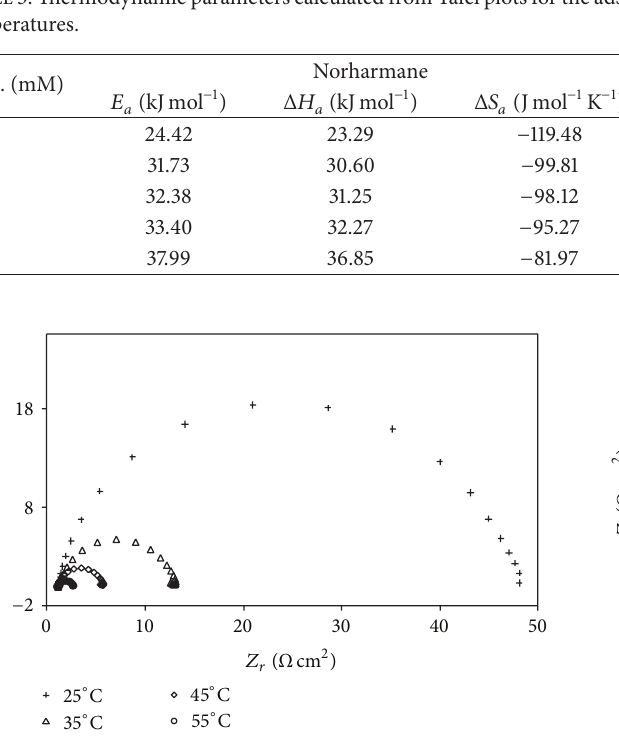
Figure 8: Nyquist diagrams for C38 steel in 1M HCl at different temperatures.